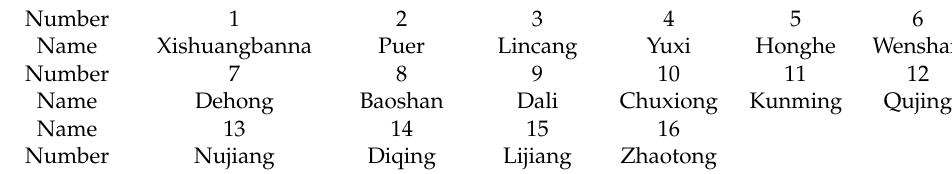
Table 2. Names of all sites in YP and their corresponding site